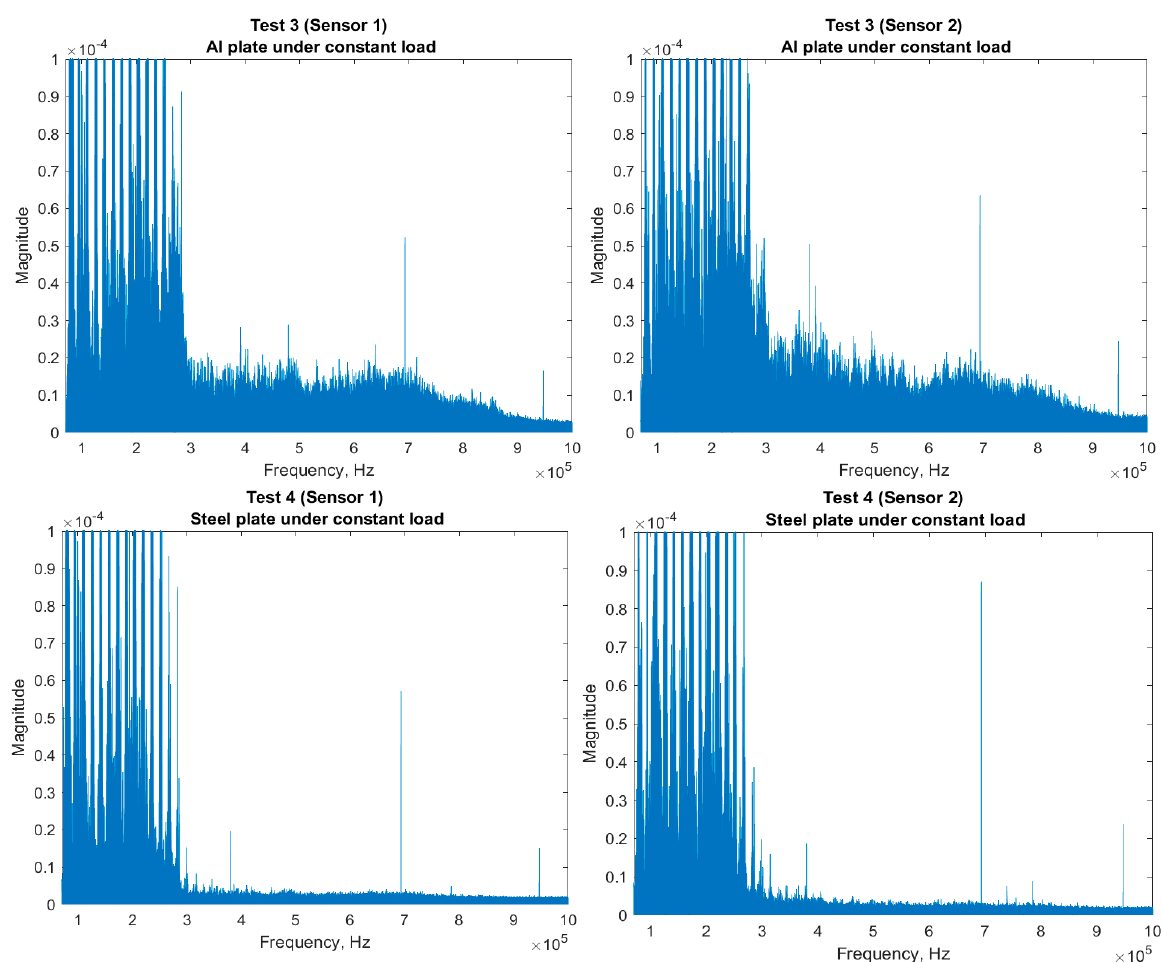
Figure 15. FFTs of tool steel on Al sheet (top) and tool steel indenter on steel sheet (bottom) under constant load. Left, sensor 1. Right, sensor 2.